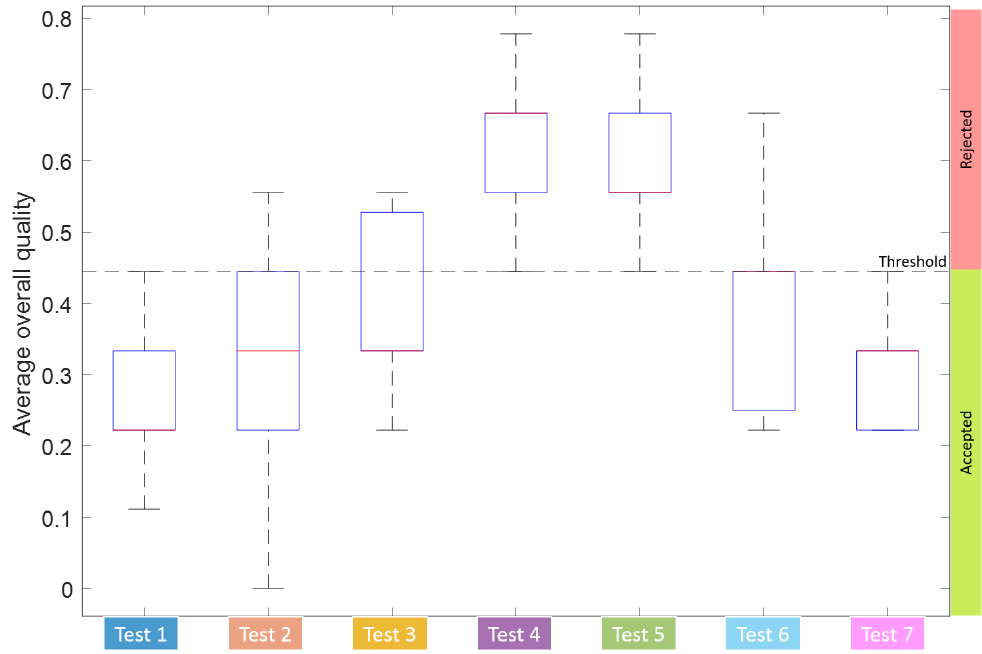
Figure 15. Box plot showing the quantification of the quality produced in each test after the acceptance criteria have been applied to the measured